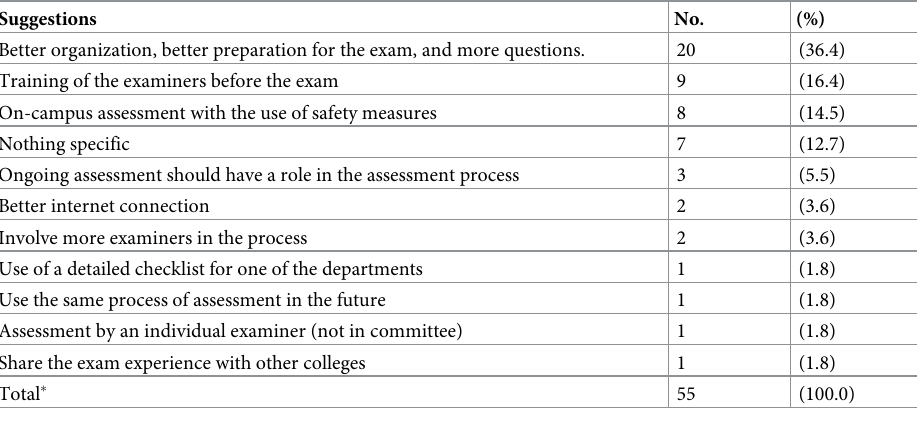
Table 7. Examiners’ suggestions for